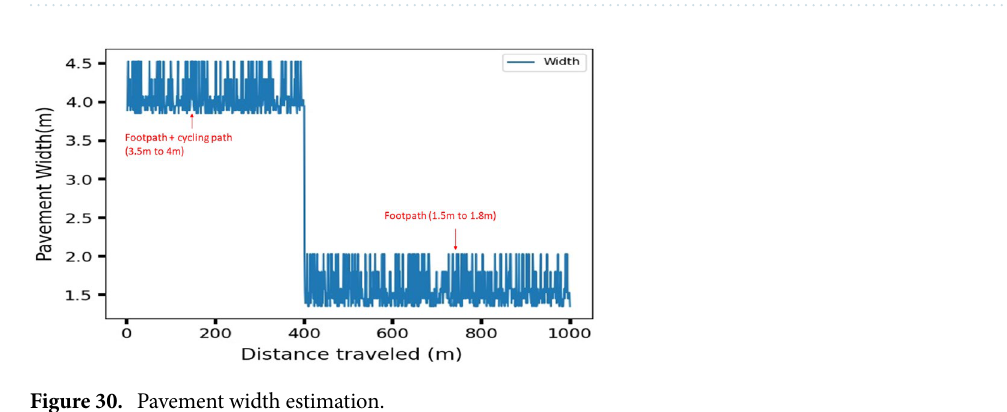
Figure 29. Offline results: pavement width estimation from pavement segmented region.